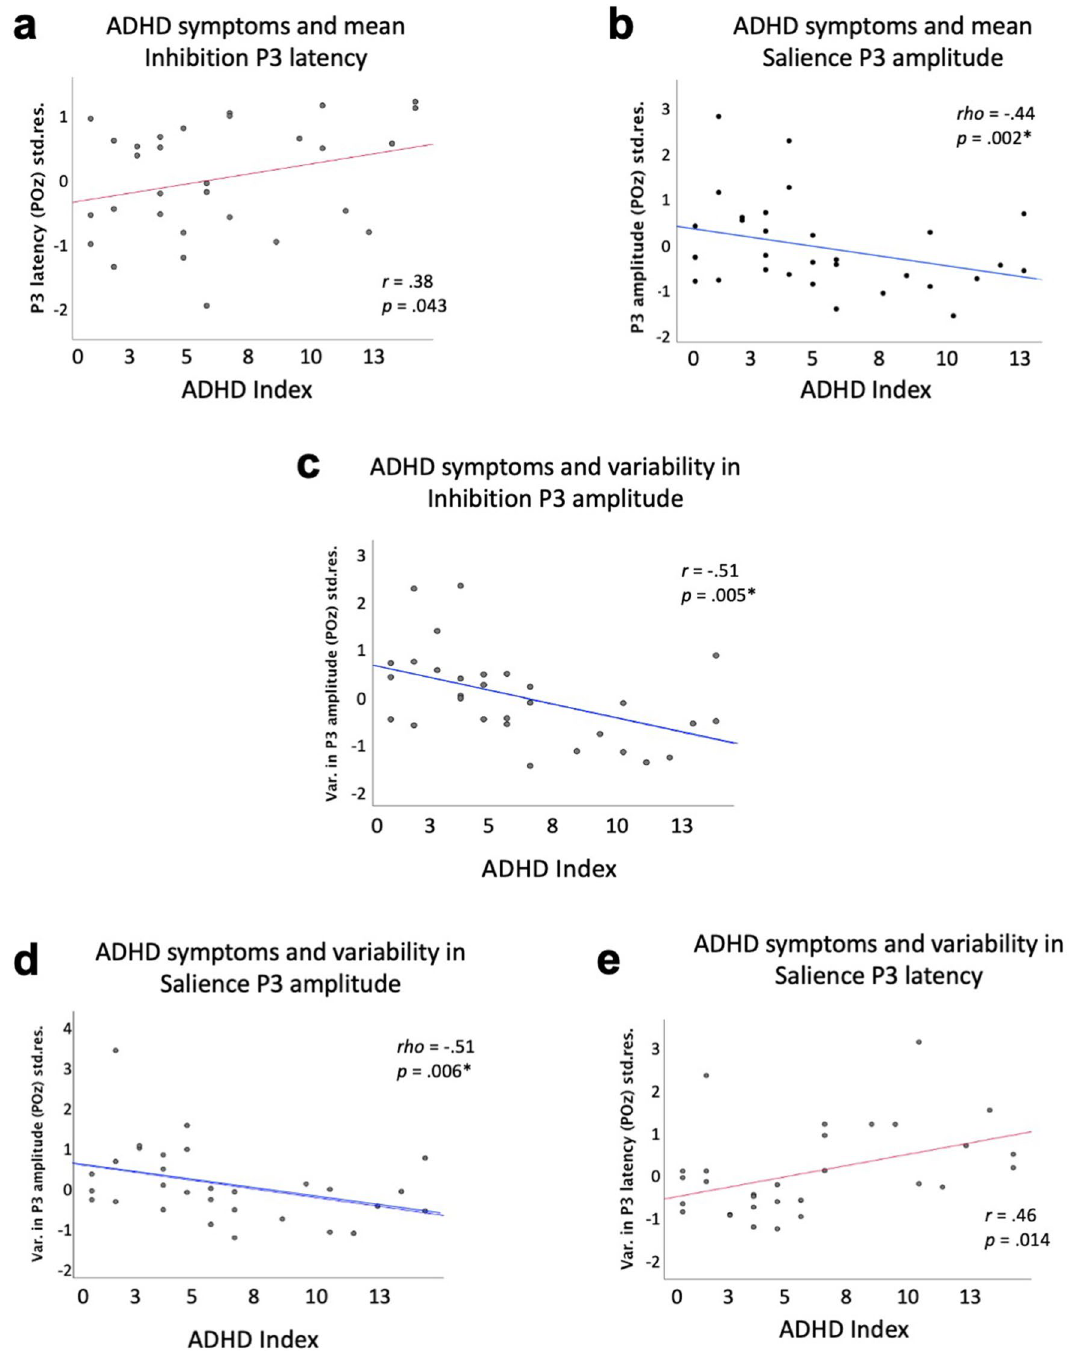
Figure 5. Scatterplots for significant associations between ADHD Index and neuronal markers of inhibition and salience processing, after controlling for effects of age, sex, and general intelligence. For illustration of partial correlations, the y -axis depicts the standardized residuals resulting from linear regression of age, sex, and general intelligence (SPM raw score) on the neural marker of interest (i.e., the signed area amplitude or fractional area latency; see Methods). ( a ) Higher ADHD Index is descriptively associated with increased latencies of the inhibition-related P3. ( b ) Higher ADHD Index is significantly associated with higher amplitude of the salience- related P3. ( c ) Higher ADHD Index is significantly associated with less variability in the amplitude of the inhibition-related P3. ( d ) Higher ADHD Index is significantly associated with less variability in the amplitude of the salience-related P3. ( e) Trend-level support for an association between higher ADHD Index and higher variability in the latency of the salience-related P3. Associations passing the Bonferroni corrected-threshold of p = .0125 (four comparisons) are marked with an asterisk. r . , partial Pearson’s correlation coefficient for the partial correlation controlling for effects of age, sex, and SPM raw scores; rho , , partial Spearman’s rank order correlation coefficient for the partial correlation controlling for effects of age, sex, and SPM raw scores (used when data violates significantly the assumption of normality). Std.res., standardized residuals; Var.,